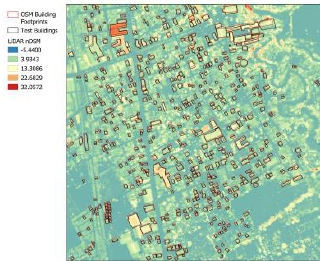
Figure 4. Manually digitized test buildings and the corresponding OSM building footprints.